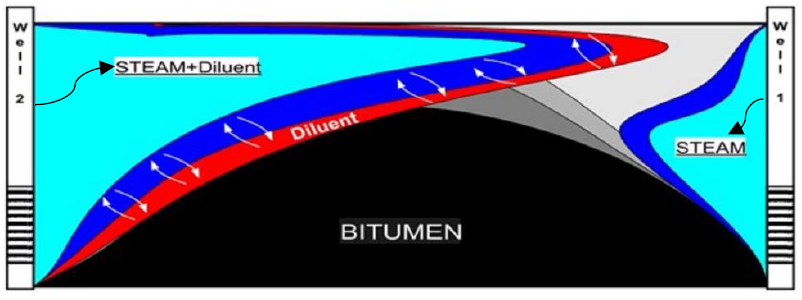
Figure 3. Schematic diagram of LASER [28].